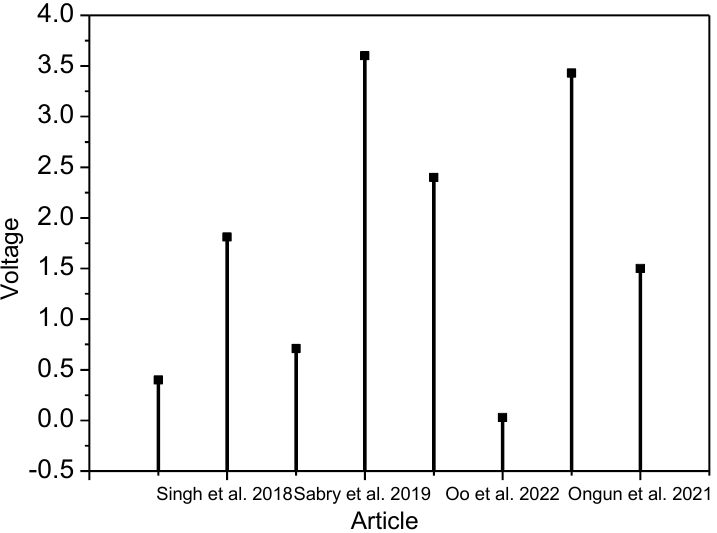
Figure 1. Output voltage measured in different articles in literature review.